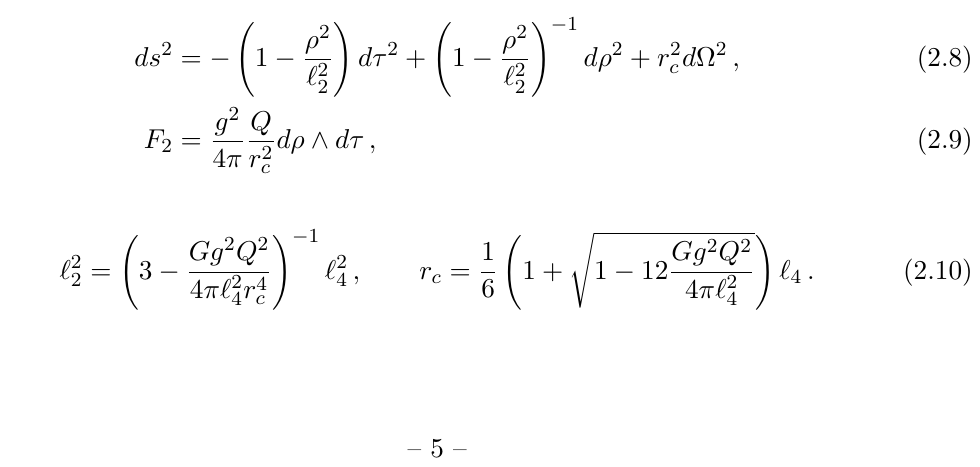
JHEP10(2021)009